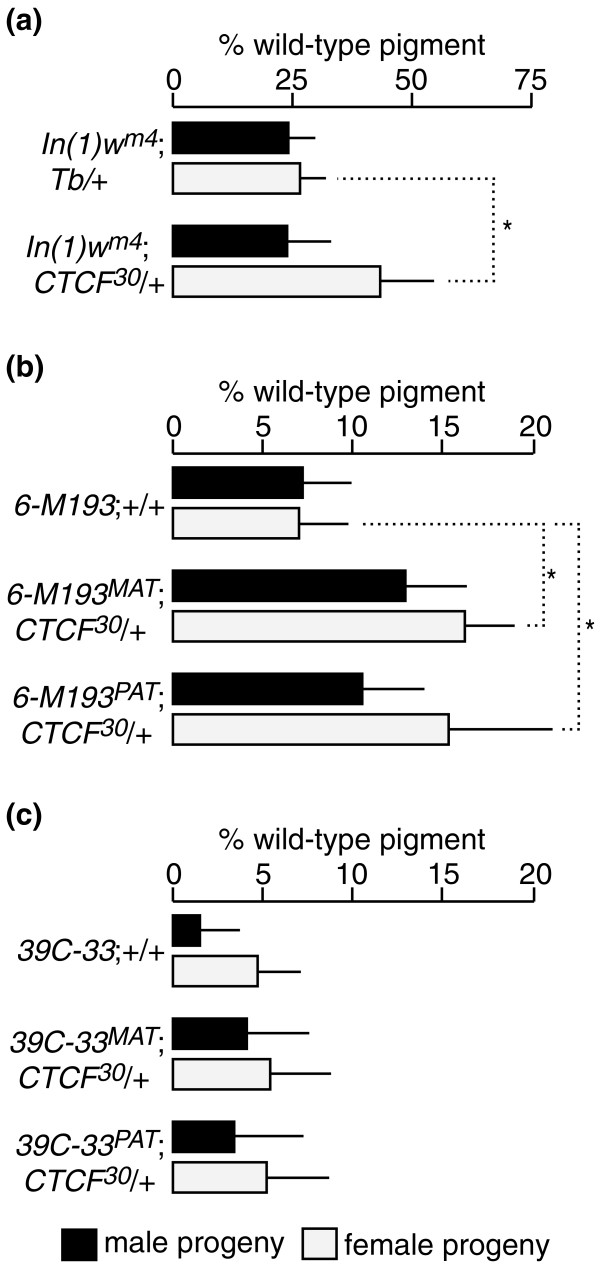
The effect of CTCF30 on white variegation in In(1)wm4 and the fourth chromosome variegating strains 6-M193 and 39C-33. (a) Pigment levels were measured for In(1)wm4/w1118;CTCF30/+ and In(1)wm4/Y;CTCF30/+ genotypes compared with the corresponding sibling In(1)wm4;Tb/+ controls. In(1)wm4 heterozygous for CTCF30 results in an increase in white expression; however, this increase is only significant in female progeny (white bars). Red pigment quantification mean values for each group are based on n = 10 (50 heads total). Error bars represent standard deviation, and values significantly different from the controls are marked with an asterisk (P < 0.001). (b) Pigment levels were independently measured for both the maternally (6-M193MAT) and paternally (6-M193PAT) inherited fourth chromosome variegator 6-M193. 6-M193 heterozygous for CTCF30 results in an increase in white expression when either maternally or paternally inherited; however, this increase is only significant in female progeny (white bars). Red pigment quantification mean values for each group are based on n = 9 (45 heads total) for 6-M193MAT male and female progeny; n = 10 (50 heads total) for 6-M193PAT male and female progeny; 6-M193;+/+ control male progeny; and n = 12 (60 heads total) for 6-M193;+/+ control female progeny. Error bars represent standard deviation, and values significantly different from the controls are marked with an asterisk (P < 0.001). (c) Pigment levels were independently measured for both the maternally (39C-33MAT) and paternally (39C-33PAT) inherited fourth chromosome variegator 39C-33. 39C-33 heterozygous for CTCF30 results in no significant change in white expression when either maternally or paternally inherited. Red pigment quantification mean values for each group are based on n = 10 (50 heads total) for 39C-33MAT and 39C-33PAT male and female progeny, and n = 20 (100 heads total) for 39C-33;+/+ control male and female progeny. Error bars represent standard deviation.